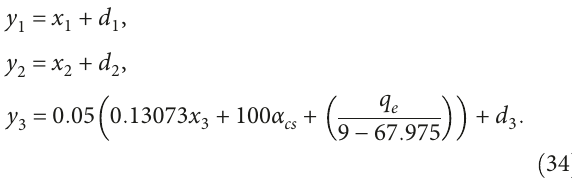
Figure 3: Block diagram used to implement the receding Galerkin method with the state